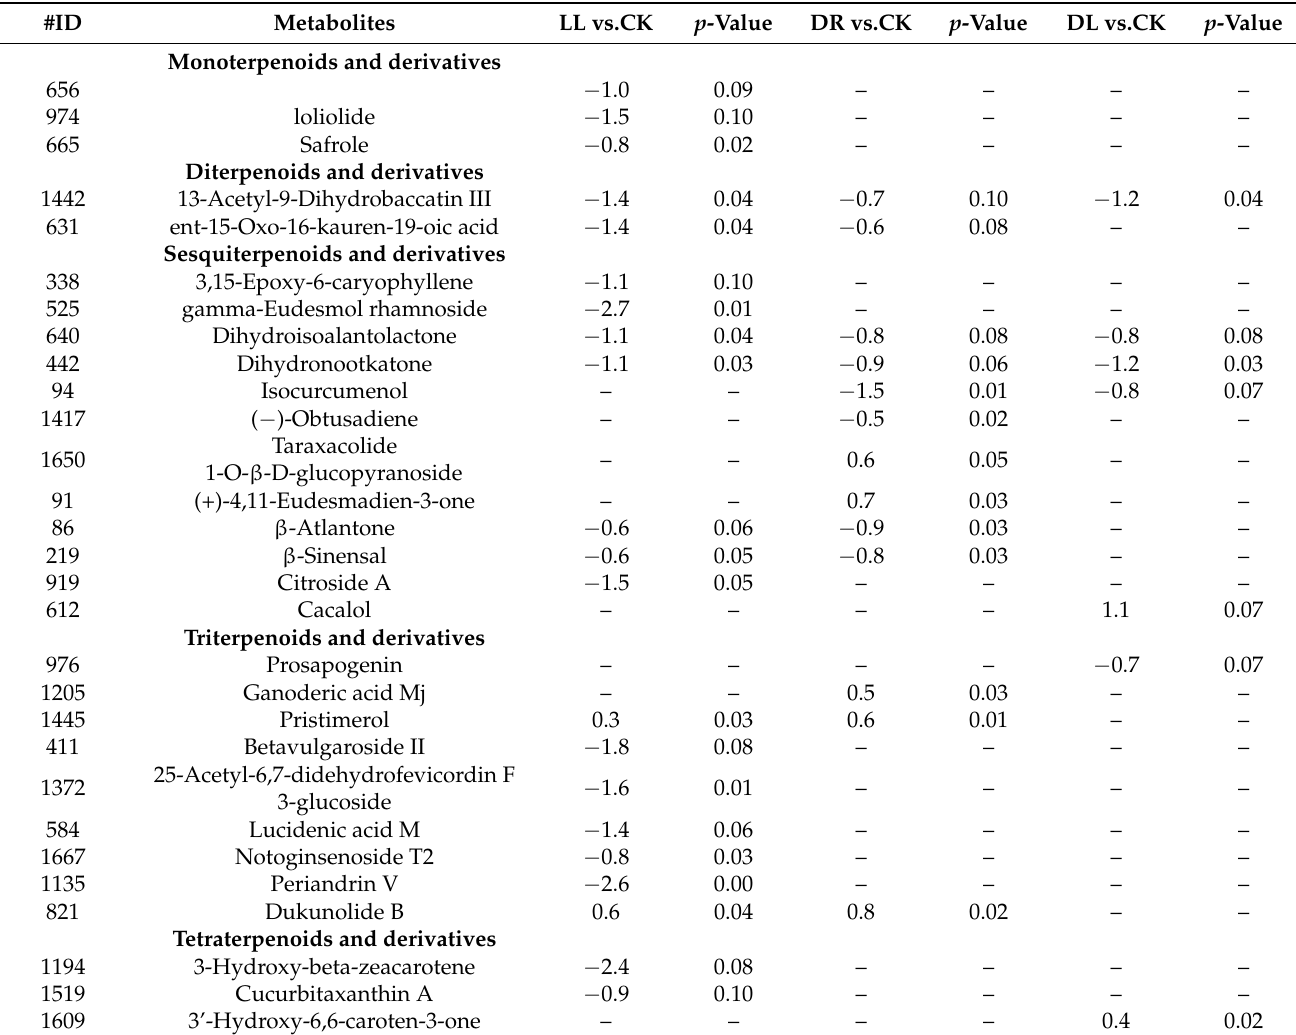
Table 2. Fold changes of terpenoid metabolites in Masson pine seedlings under low light, drought, and their combined stresses compared to control. CK: control; LL: low light; DR: drought; and DL (DR + LL): the combined stress of drought and low light. Every treatment included three individual repeats, and 20 leaves were collected from